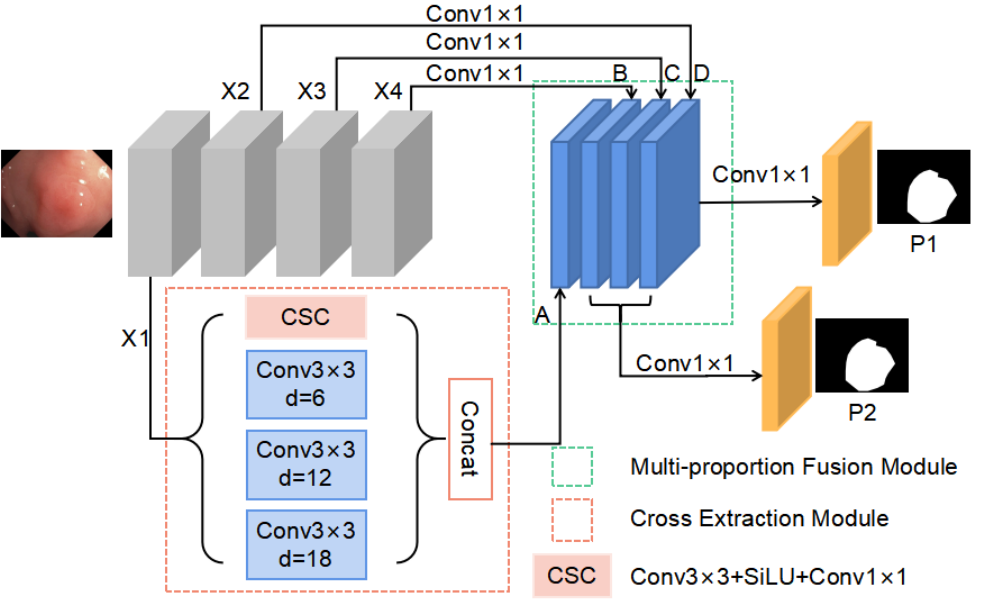
Figure 1. Structure diagram of the network.